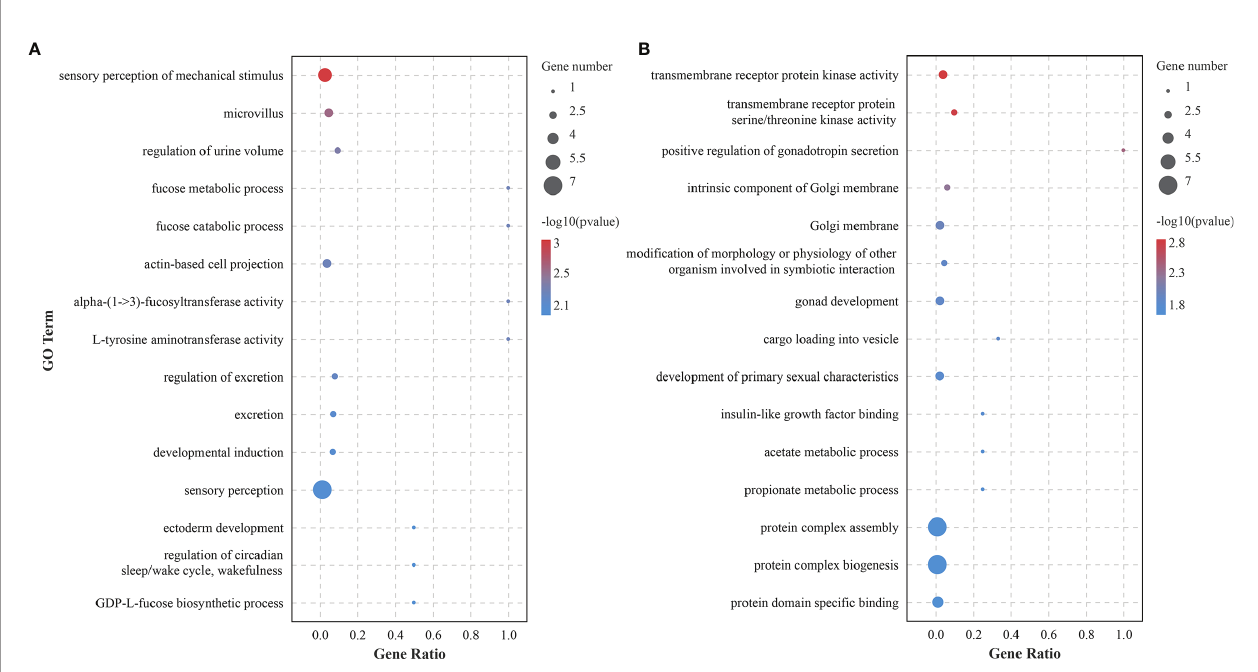
FIGURE 4 | Gene Ontology (GO) enrichment analysis of host genes of differentially expressed circular RNAs (circRNAs) (A) and mRNAs (B) involved in the competing endogenous RNA (ceRNA)